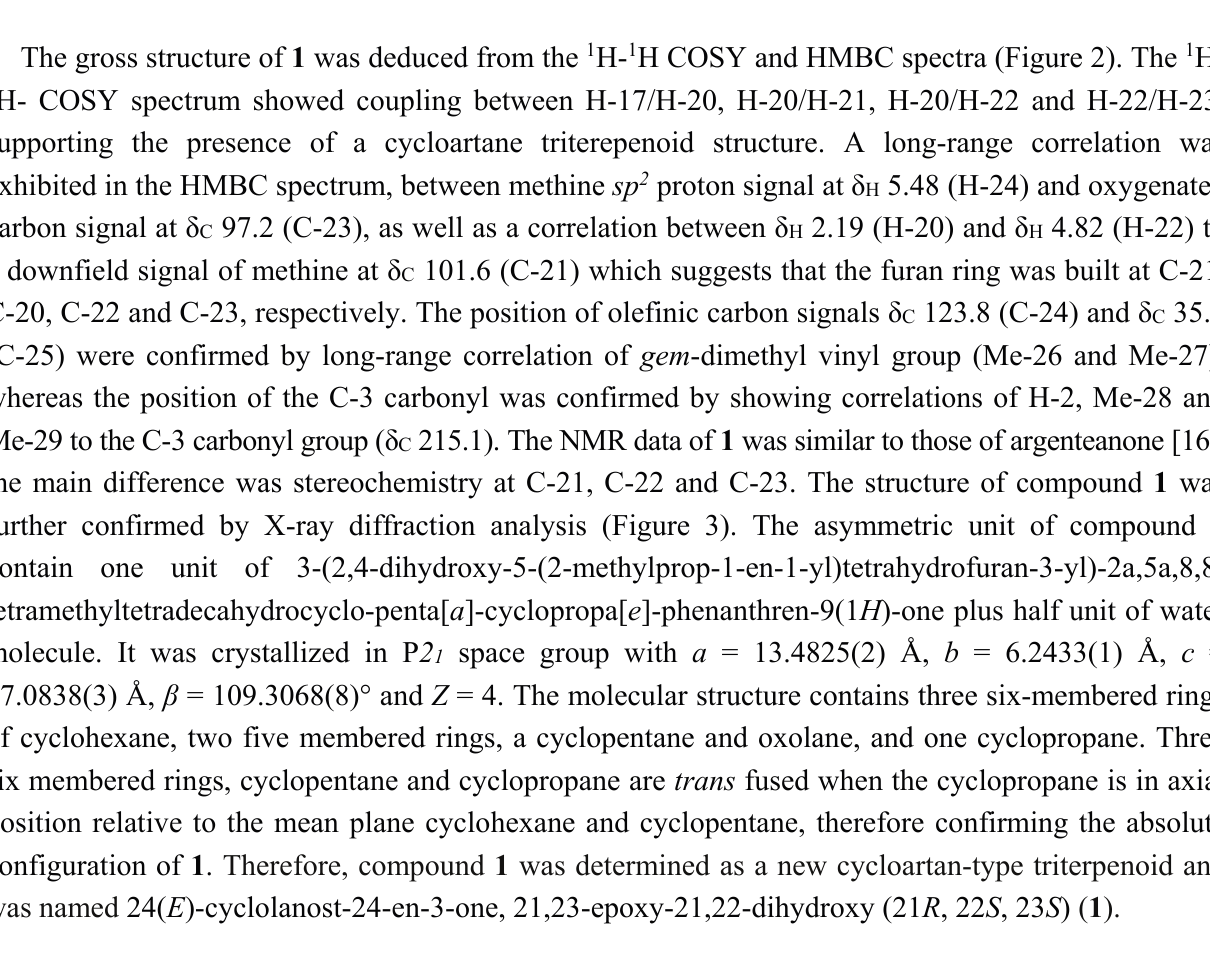
Figure 1. 9,19-Cyclolanost-24-en-3-one,21,23-epoxy-21,22-dihydroxy (21 R , 22 S , 23 S ) ( 1